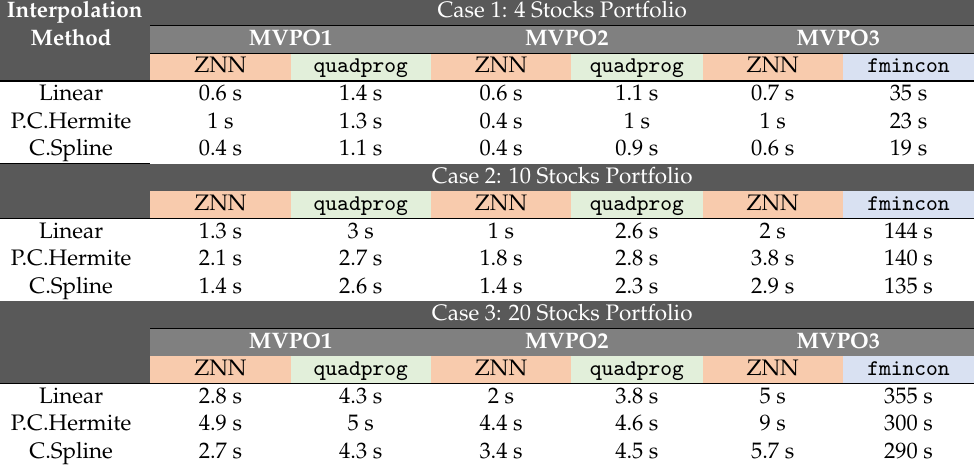
Table 2. The ZNN and MATLAB’s solvers time consumption for solving the MVPO problems.